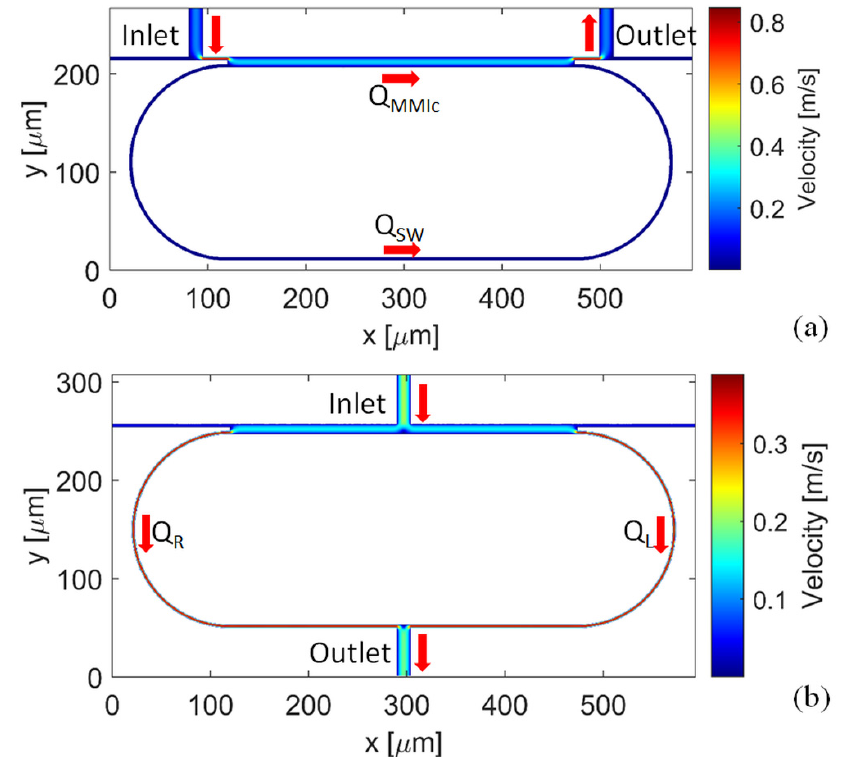
Figure 3. Three-dimensional steady-state flow profile of the ( a ) unbalanced and ( b ) balanced fluidic ring scheme.